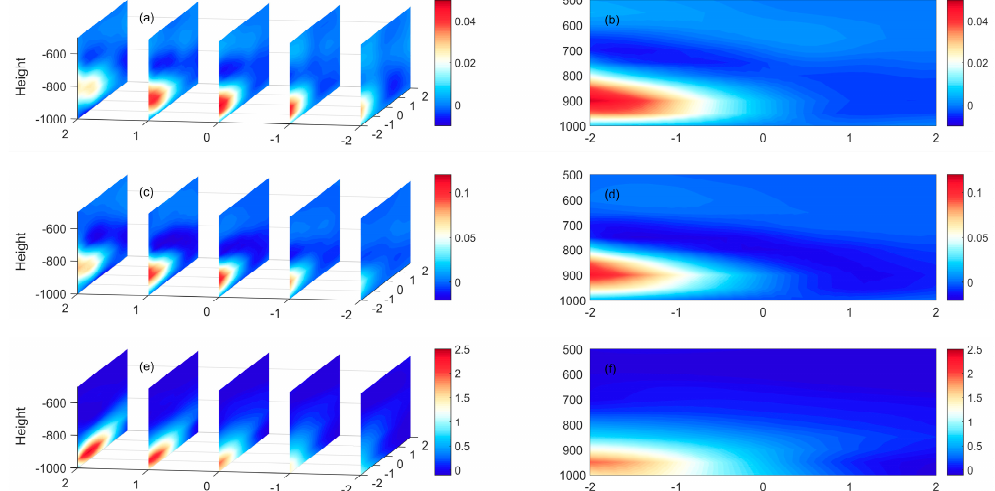
Figure 13. Left panel: Composites of the vertical velocity anomalies (( a ), units: Pa · s − 1 ), the vertical transport anomalies of transient zonal momentum (( c ), units: Pa · m · s − 2 ), and the wind speed anomalies (( e ), units: m · s − 1 ). Right panel ( b , d , f ): the middle section in left panel, which is at the latitude of the GW center.